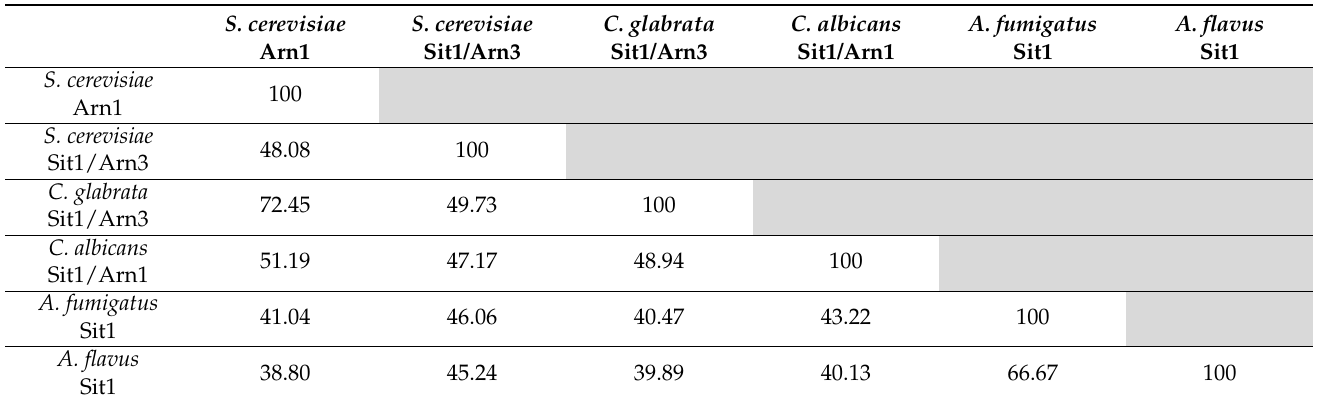
Table 2. Percent sequence identity of siderophore